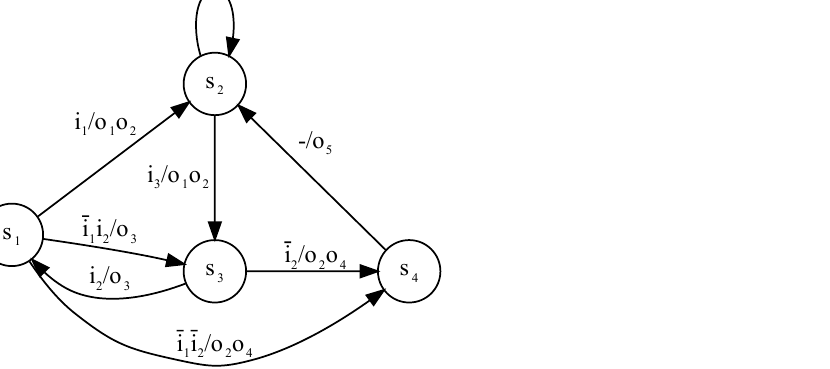
Figure 1. The state transition graph of Mealy finite state machine (FSM) A 1 .